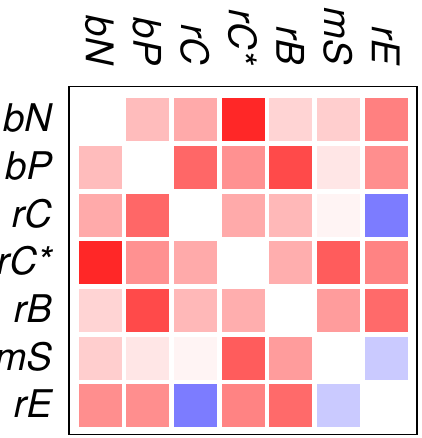
Figure 4. Summary of co-occurrence data. See text for